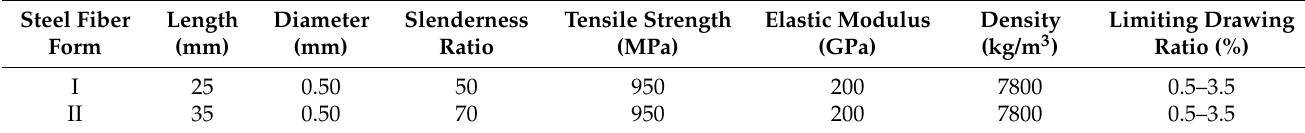
Table 2. C35 concrete mix proportions.